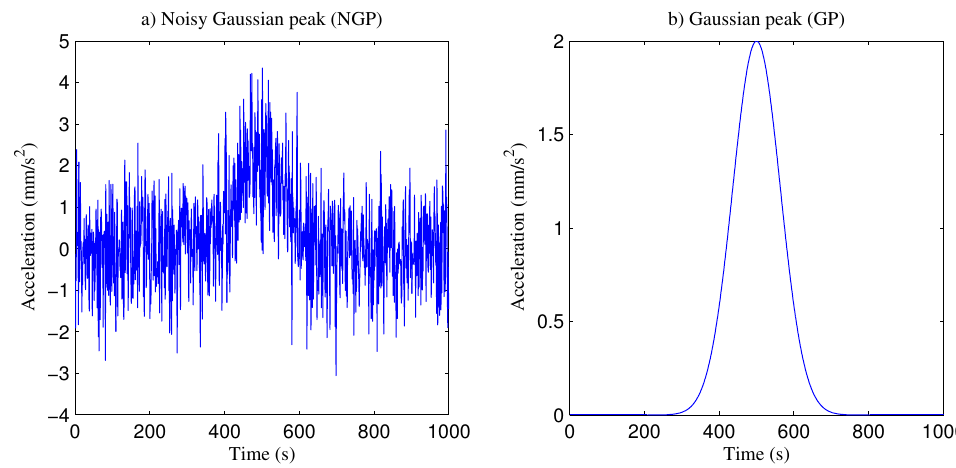
Figure 9. The Gaussian peak for the analysis: ( a ) with white noise; ( b ) without